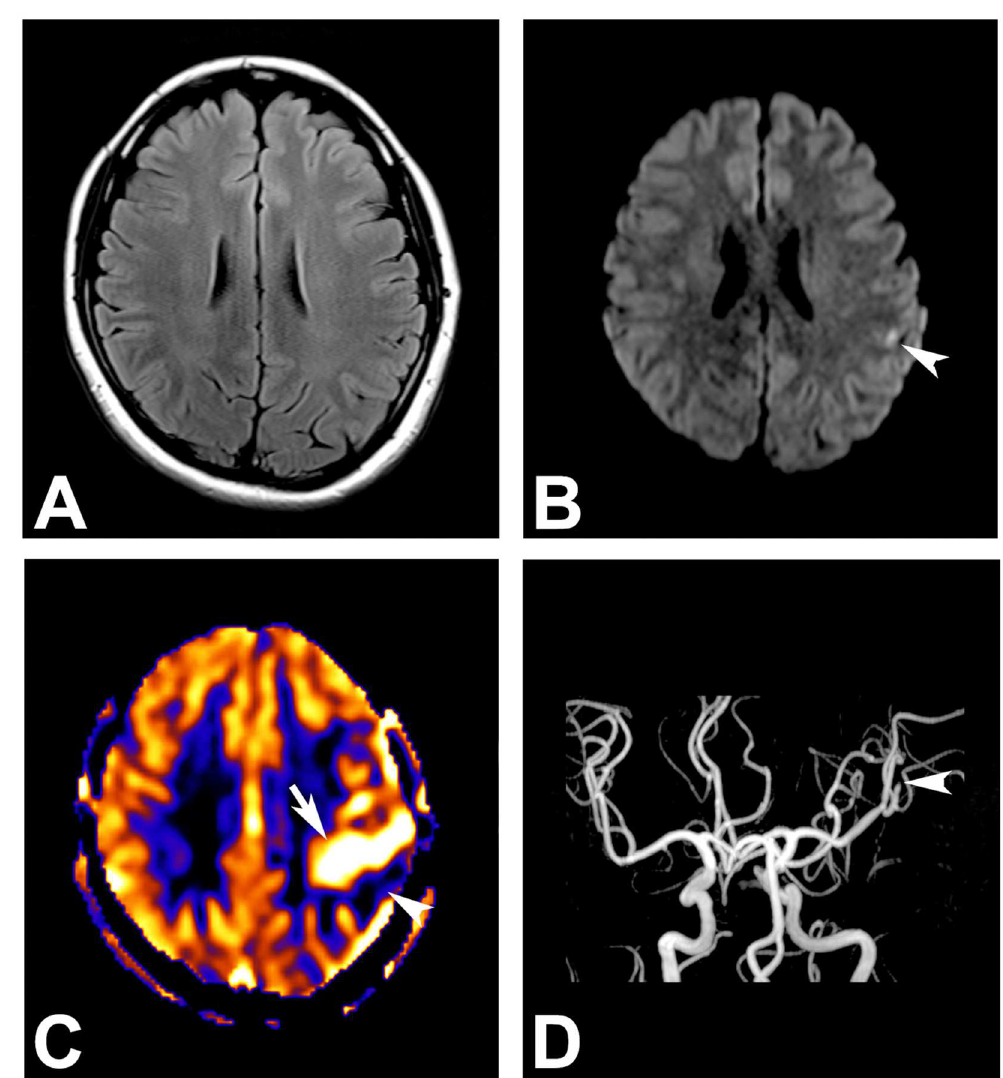
Fig 4. A 33-year-old woman who visited the emergencydepartment for a nonconvulsive seizure. (A) Brain parenchyma appearsnormal on the T2 FLAIR image. (B) A tiny dot-like diffusionrestriction is noted at the left parietalcortex (arrowhead). (C) Arterial spin labelingperfusion-weightedMR image depicts hyperperfusion at the left middlecerebralartery territory (arrow). Note the combinedhypoperfusion portion adjacent to the hyperperfused area (arrowhead). (D) MR angiography reveals occlusion at the left M2 segment (arrowhead).